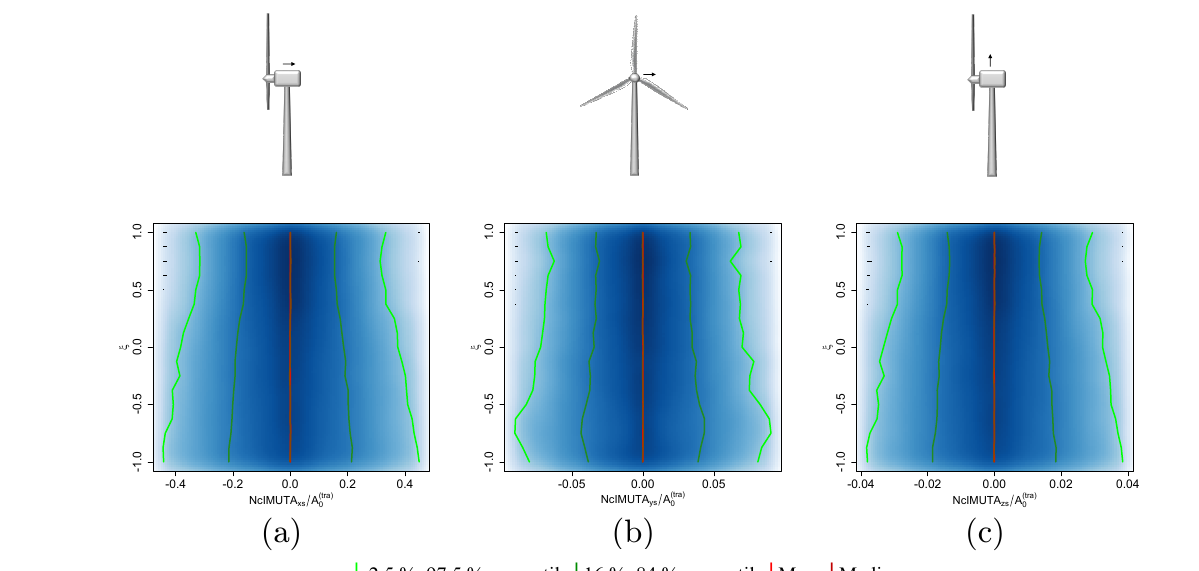
Figure 3. Variation with ξ of the PDFs of the nacelle’s translational accelerations. (a) Streamwise. (b) Spanwise. (c) Vertical. The parameter ξ is represented by the vertical axis, starting with an entirely positive shear at the bottom (where ξ = − 1) and ending with an entirely negative shear at the top (where ξ = 1). The horizontal axis represents values of the nacelle’s translational acceleration (NcIMUTA) normalized by a reference ( A (tra) ). The background color is deeper where values are more concentrated. The red line and the dark red line (overlapped in this 0 plot) connect the mean and the median values, respectively. The green lines and the dark green lines delimit the zones encompassing 95 and 68% of the values,